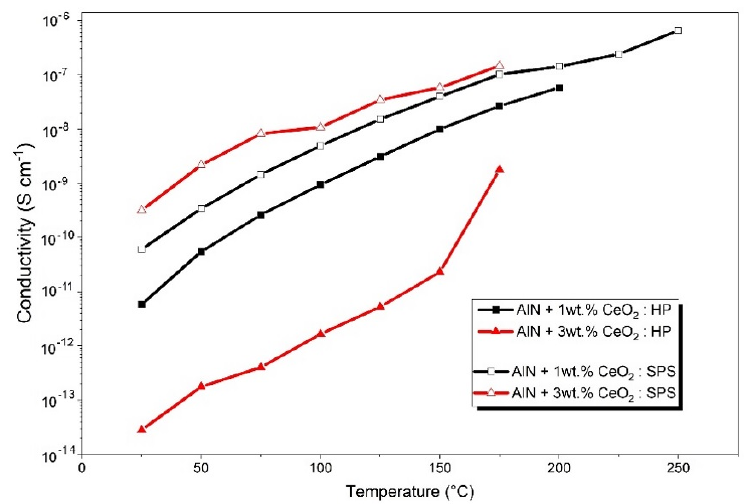
Figure 15. Thermal evolution of the global conductivity of AlN + 1wt.% CeO 2 and AlN + 3wt.% CeO 2 . Comparison between HP and SPS CeO 2 . Comparison between HP and SPS samples.